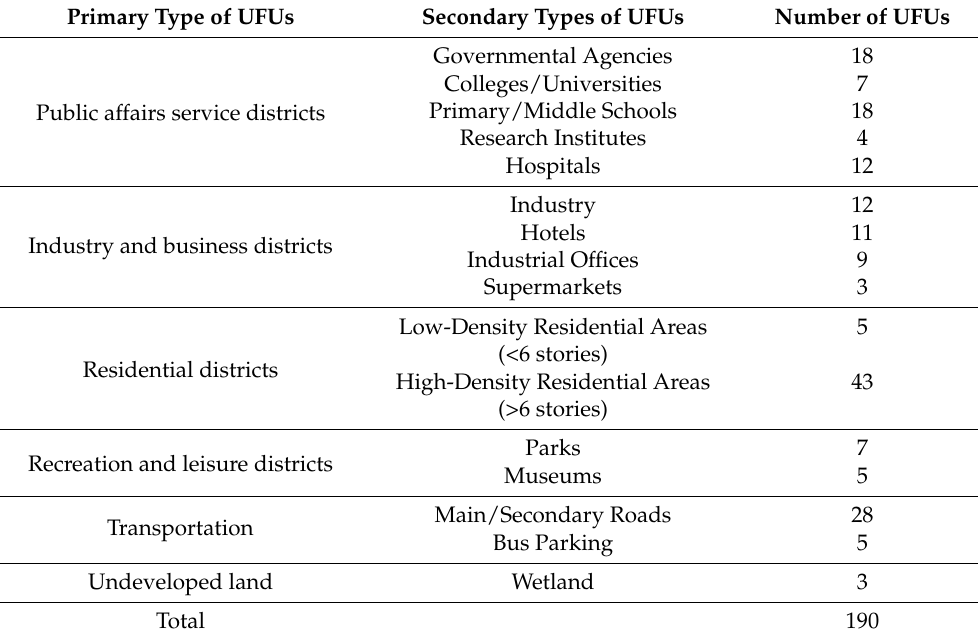
Table 1. Number of primary and secondary urban function units (UFUs) selected in